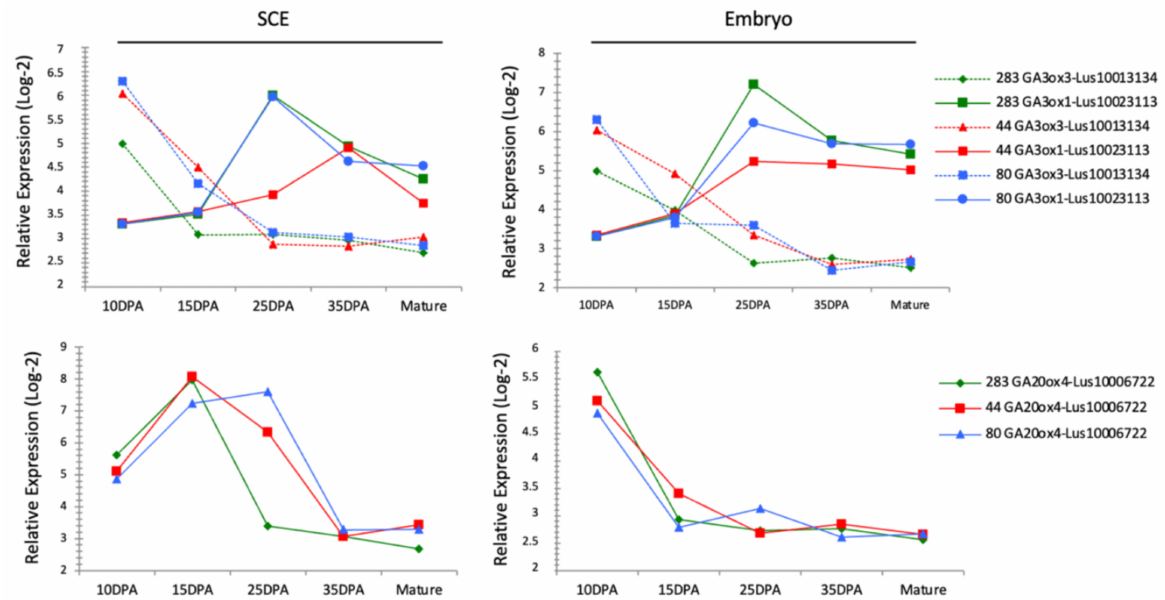
Figure 7. Expression pattern of significantly changes genes involved in the GA metabolism in flax RILs during seed development. For GA3ox or GA20ox genes, the corresponding parallel coordinates plot displays the relative genes signal intensity according to the stages of development. The relative signal intensity represents the lsmean (Log2 transformed) of the raw data extracted from the oligo microarrays analysis. Data are lsmeans of three biological replicates. Each of the genes are associated with their correScheme 283. is labelled in green, RIl 44 in red and RIL 80 in